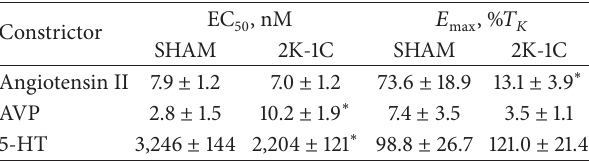
Figure 3: Dose-response effects of 5-hydroxytryptamine on tension ofproximalanddistaloccipitalarterysegmentsfromsham-operated (SHAM) and 2-kidney, 1-clip (2K-1C) hypertensive rats. The data are presented as mean ± SEM of the responses expressed as a percentage of that elicited by 80 mM K + (% 𝑇 𝐾 ). There were 8 segments in each group. Table 3: Contractile effects of angiotensin II, AVP, and 5-HT receptor agonists in common carotid arteries from 2K-1C and SHAM